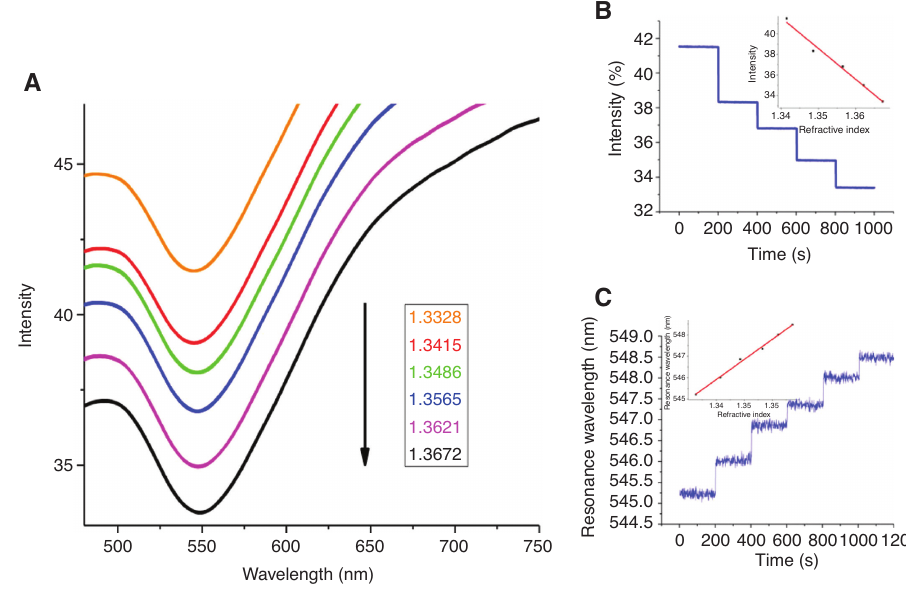
Figure 3: RI tests for fiber-optic LSPR sensors. (A) The resonance wavelength changes of fiber-optic LSPR sensors in NaCl solutions with different RI. (B) Intensity shift with RI change in solutions. (C) Wavelength shift with RI change in solutions.